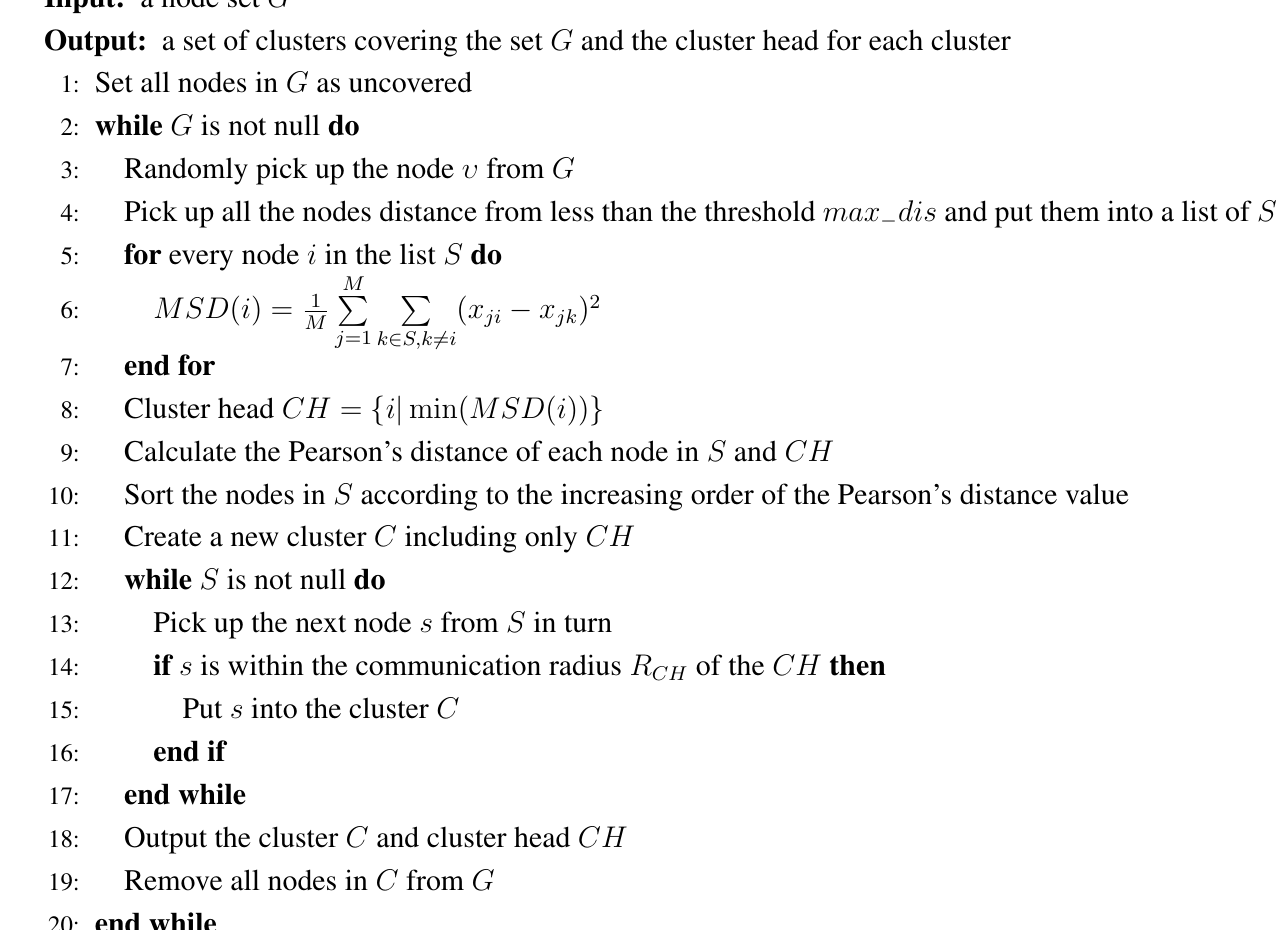
Algorithm 1 Cluster formation and cluster head selection